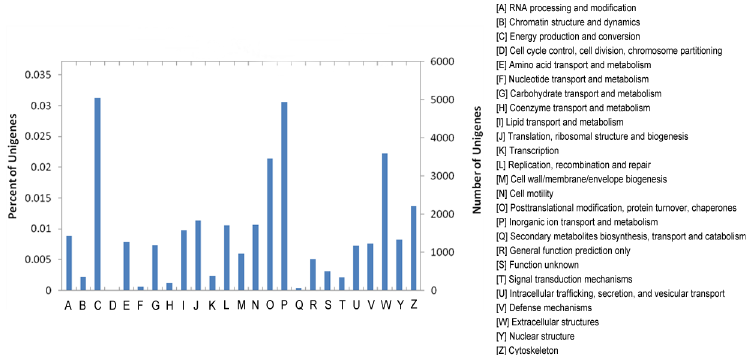
Fig 4. Cluster of orthologous groups for enkaryotic complete genomes (KOG) classification. A total of 23,477 sequences with KOG classifications within the 25 categories are shown.